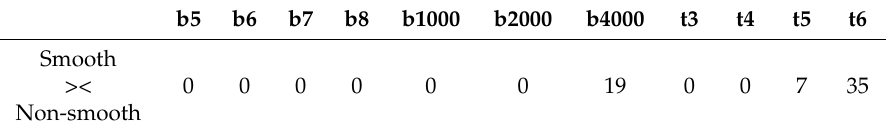
Figure 39. Comparison of the background luminance while varying the smooth parameter with the b2000 method (method with a threshold of 2000 cd/m 2 ), for all glare evaluations of the laboratory study. Table 12. Significant difference scores (%) between the smooth/non-smooth parameter (field study). Table 13. Significant difference scores (%) between the smooth/non-smooth parameter (laboratory